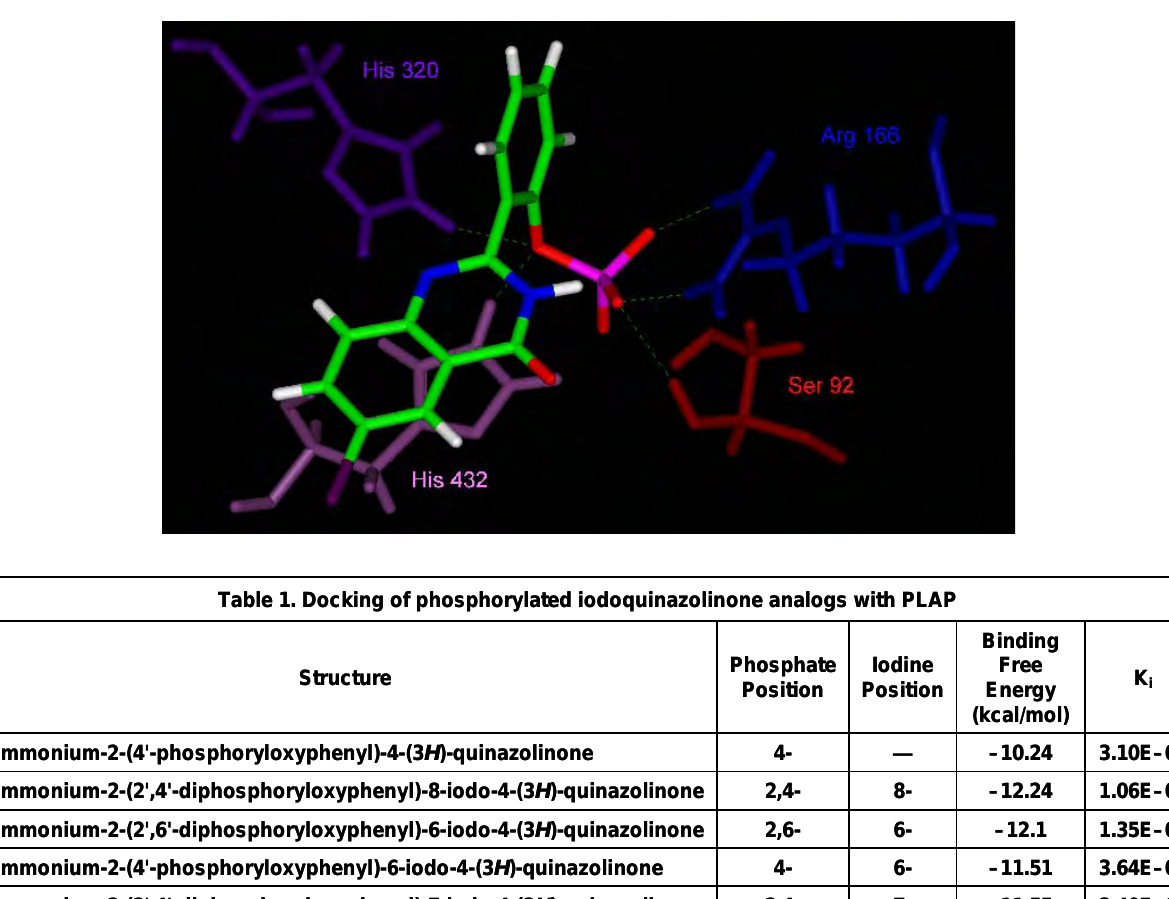
in active site of 2–P